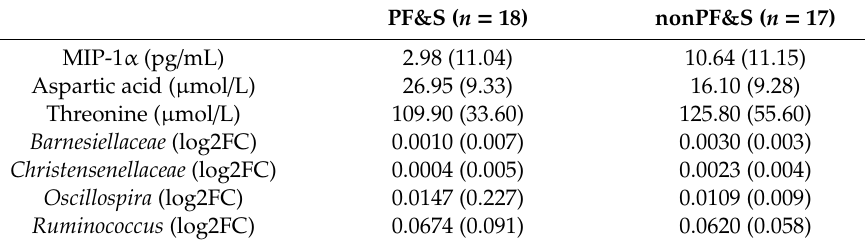
Table 4. Levels of relevant analytes as resulted from SO-CovSel